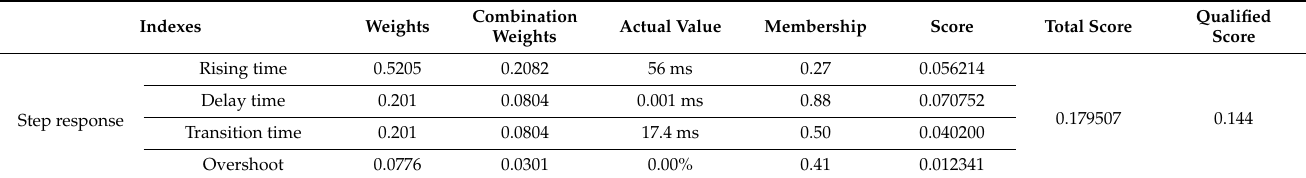
Table A2. Fuzzy PID controller speed evaluation table.